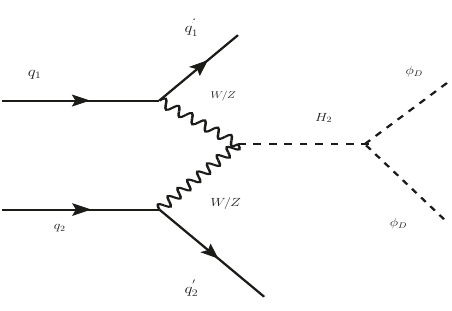
Figure 15 . Feynman diagram for the VBF process producing a pair of φ D